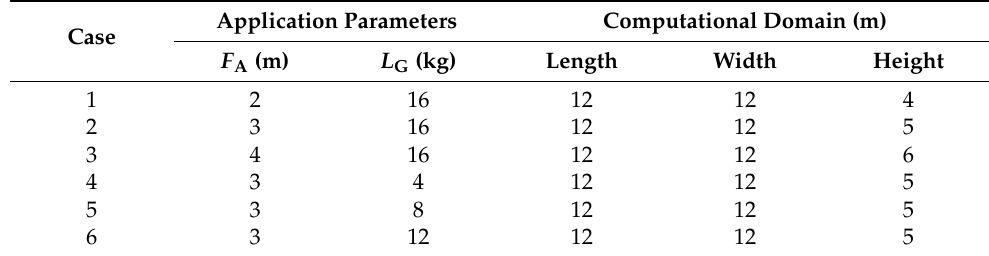
Table 3. Application parameters of the UAV sprayer in hovering and size of the computational